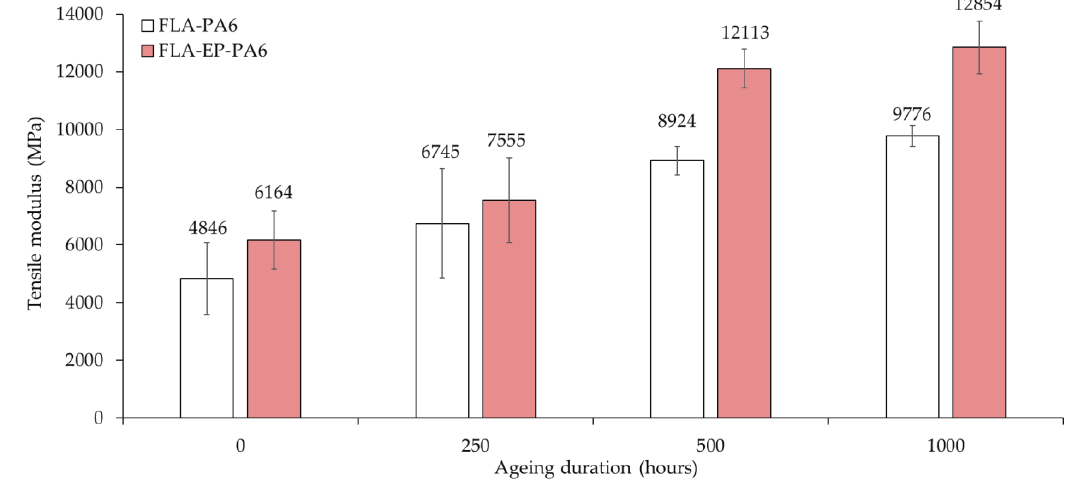
Figure 9. Tensile modulus of the biocomposites under ageing conditions.